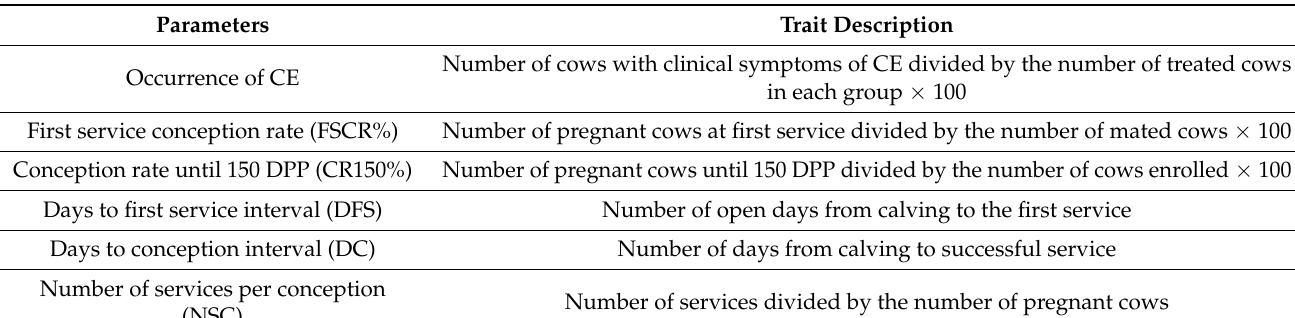
Table 1. Description of fertility parameters adopted in the study.